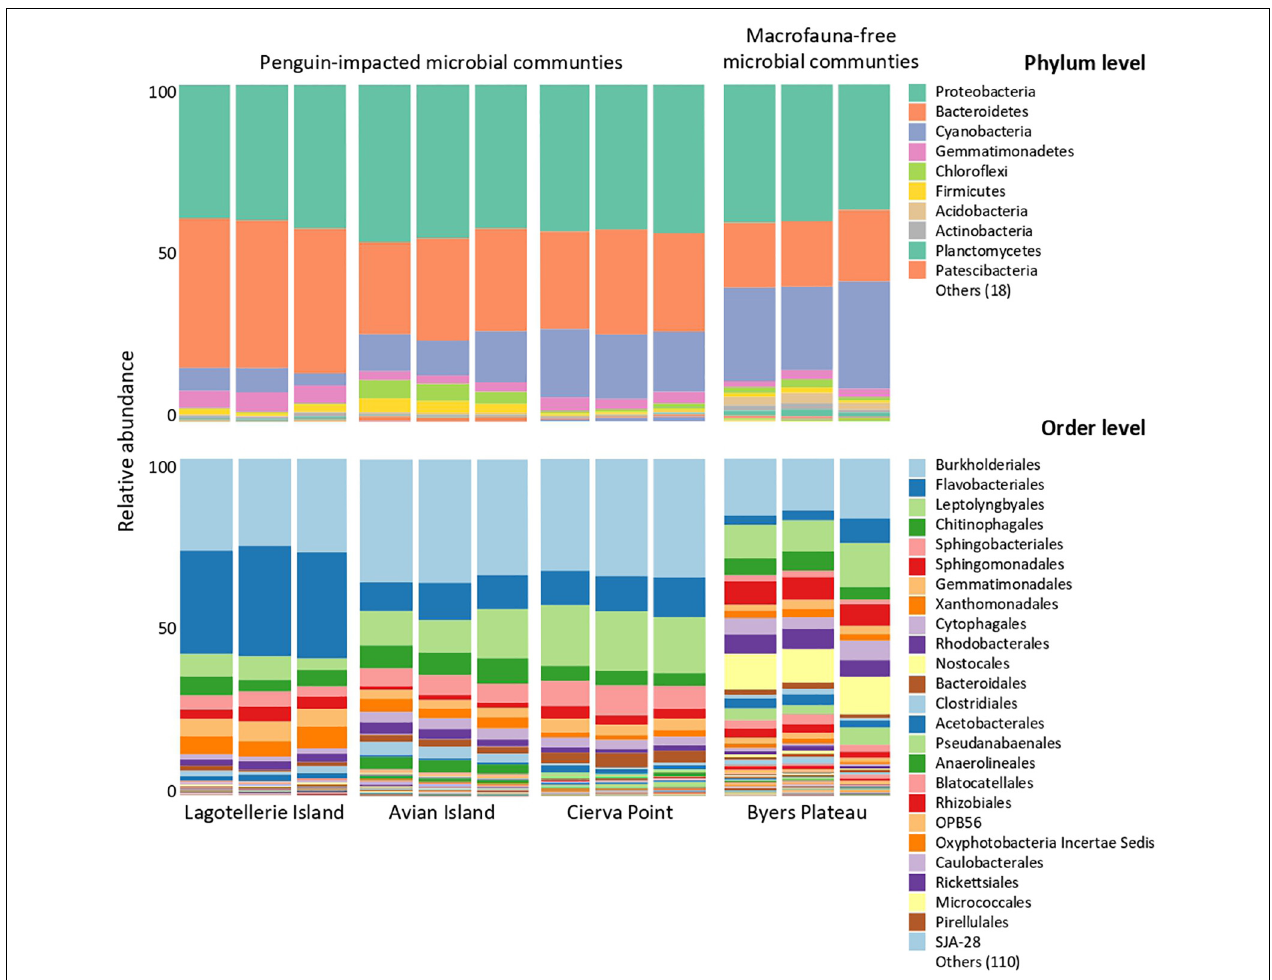
FIGURE 4 | Relative abundance of 16S rRNA genes at different taxonomic resolution (phyla vs. order) from microbial mats included in this